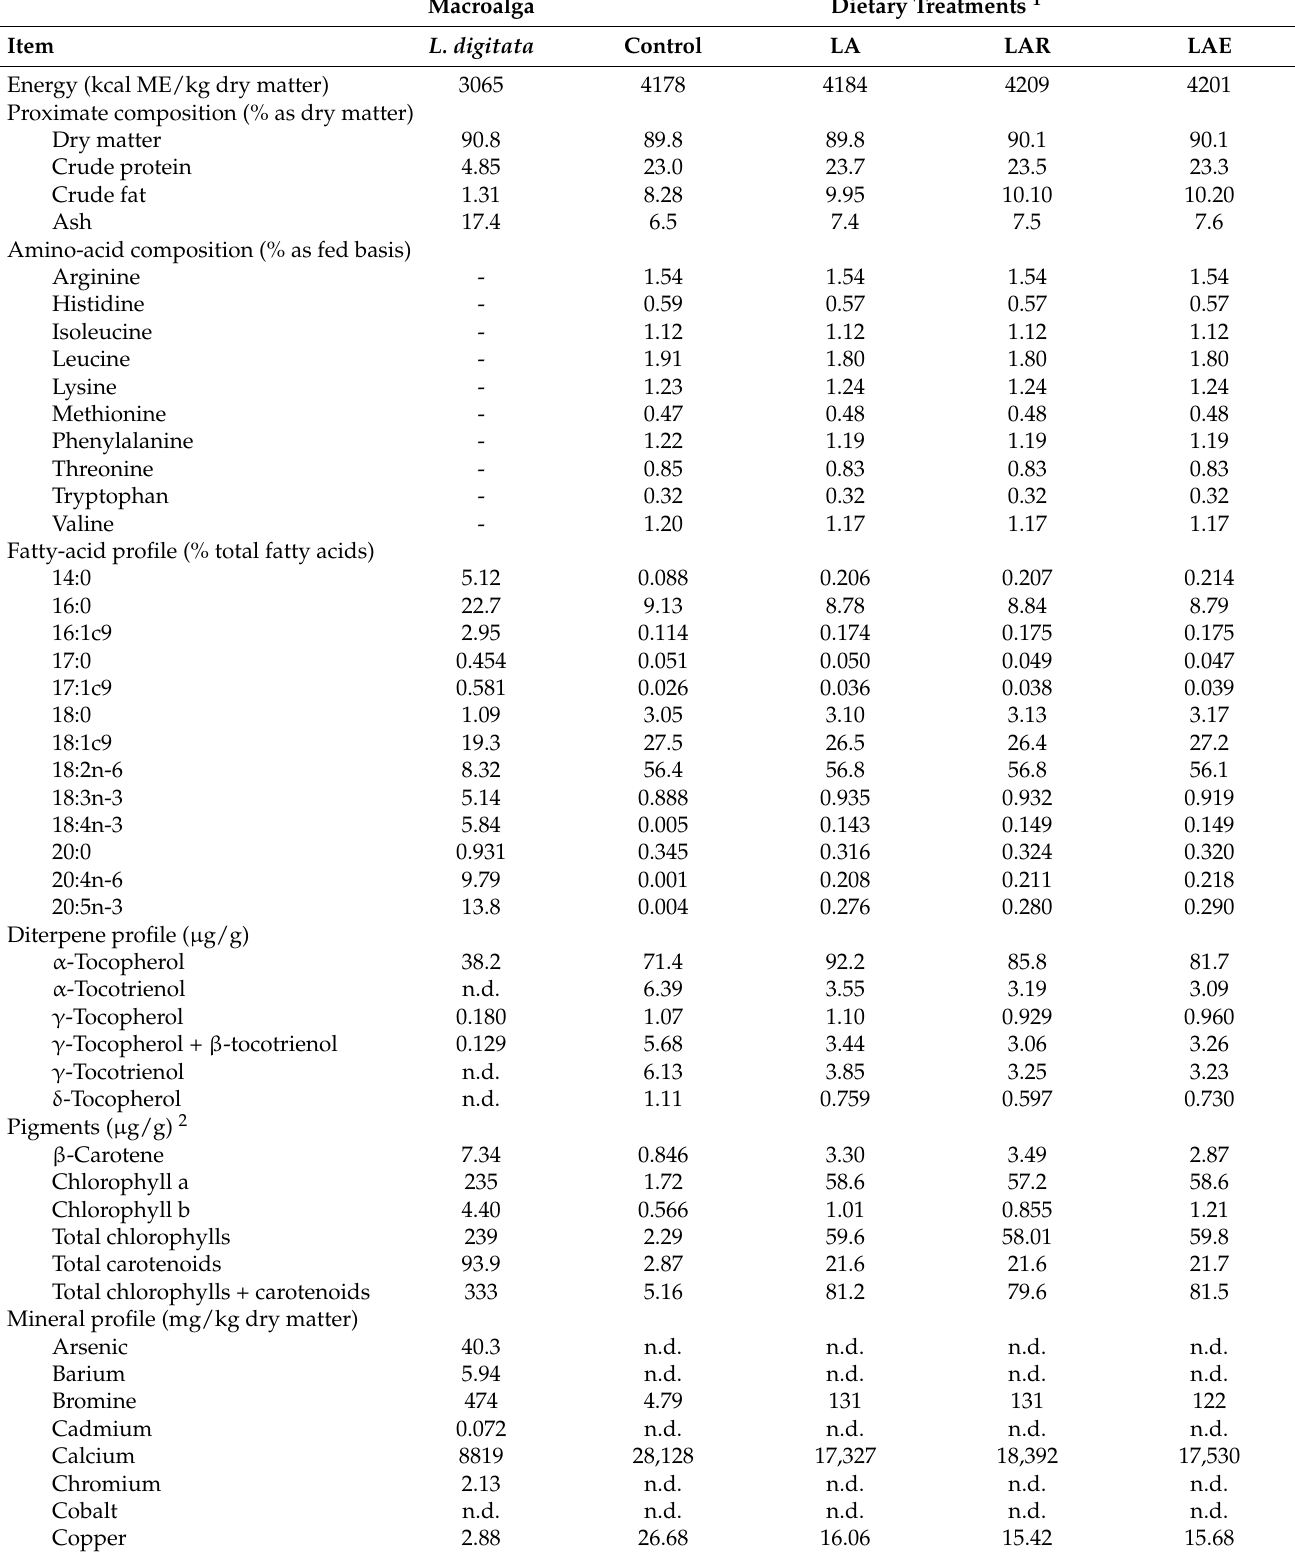
Table 2. Chemical composition of L. digitata and experimental diets. Macroalga Dietary Treatments